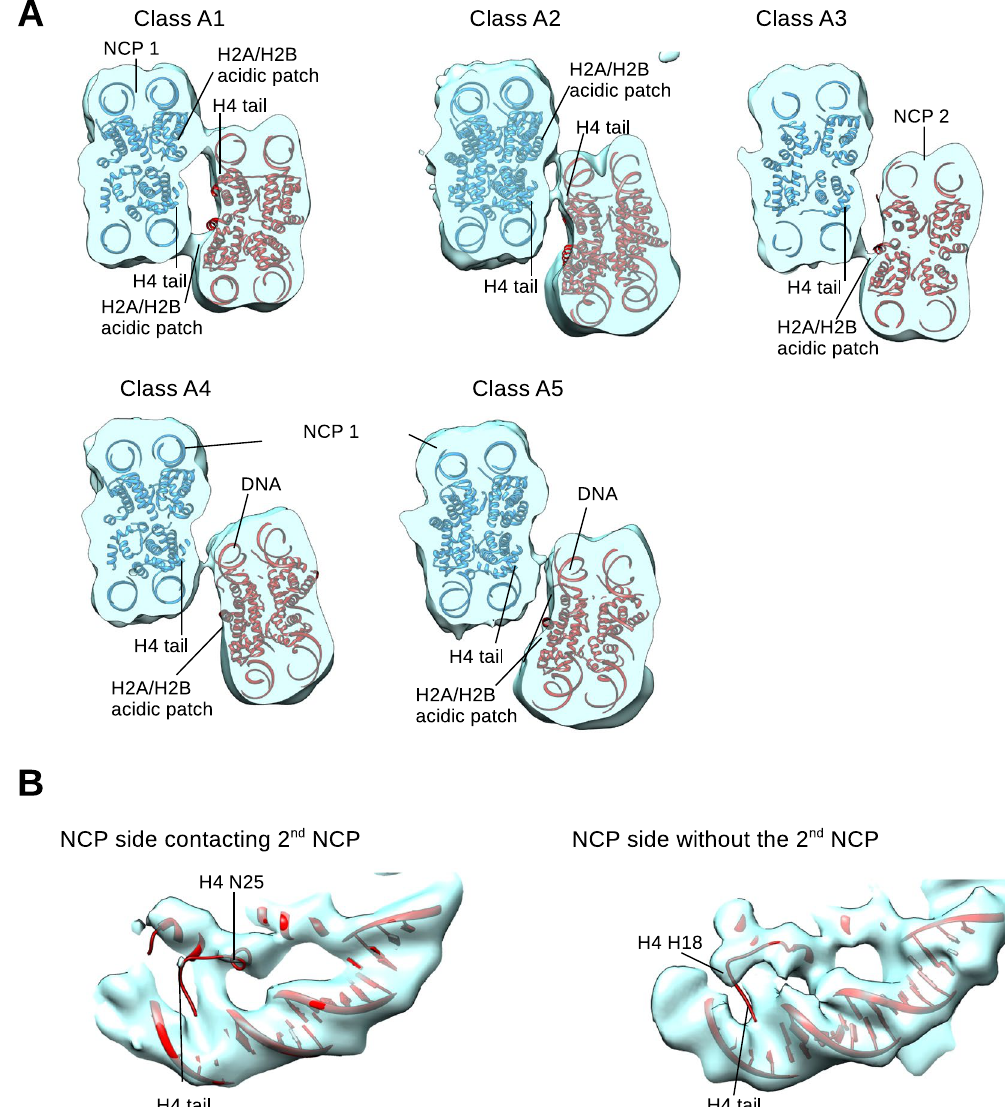
Figure 4. H4 tail makes weak interactions with H2A/H2B or DNA. ( A ) A slice through the NCP pairs of classes A1-A5 showing weaker interactions at the histone octamer interface. These contacts are presumably formed by the histone H4 tail of one NCP and the H2A/H2B acidic patch or the DNA of the second NCP. The cryo-EM density for both NCPs is shown in transparent blue. The molecular model for NCP 1 is shown in blue and for NCP 2 in red. ( B ) The cryo-EM map of the combined reconstruction of the classes A1–A3. On the histone octamer side without the adjacent NCP 2, the strong density where the N-terminus of H4 interacts with DNA at superhelix SHL 2 is visible. On the opposite side, with the adjacent NCP 2, the density for the H4 tail is not visible. This indicates that the H4 tail dissociates from the DNA of the NCP 1 and engages in intra-nucleosomal